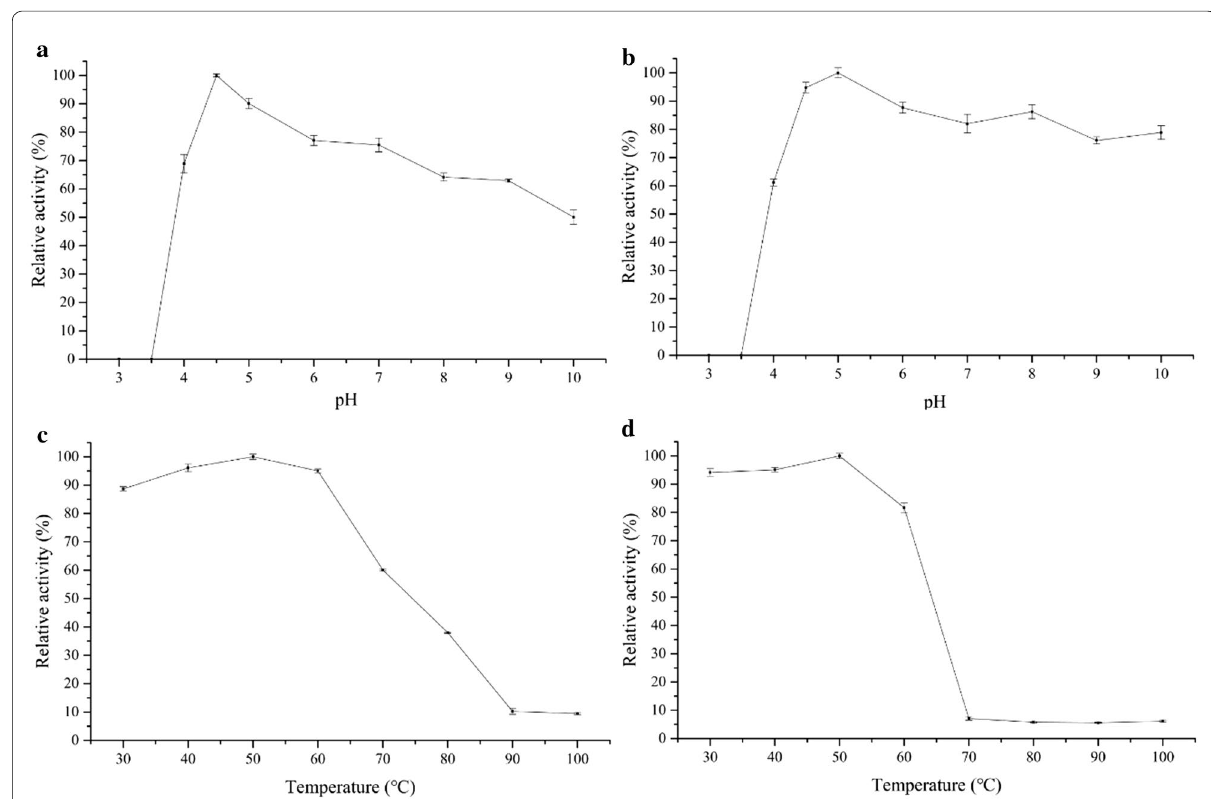
Fig. 4 Effects of pH and temperature on the activity of recombinant Cel-5A. a Optimal pH. b Stable pH. c Optimal temperature. d Stable